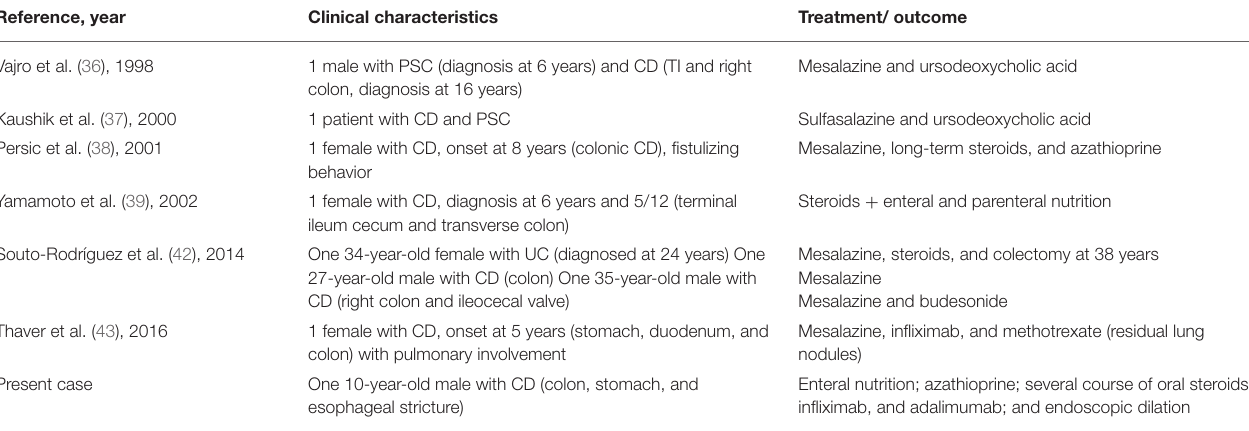
TABLE 4 | Clinical characteristics of the cases of IBD and DS detailed in literature.